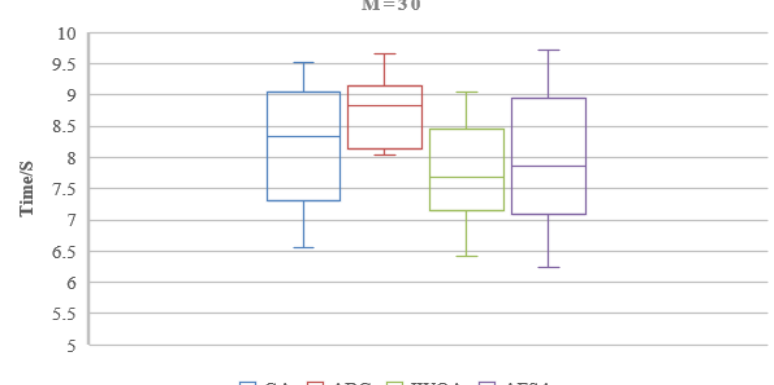
Figure 13. Running time box plot when the population is 15.